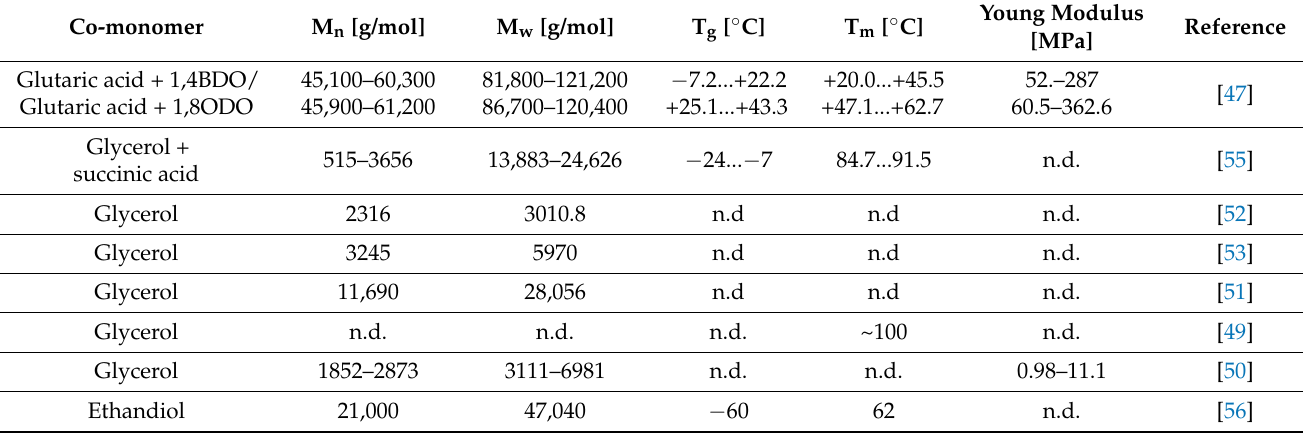
Table 2. Thermal and mechanical properties of AzA-based